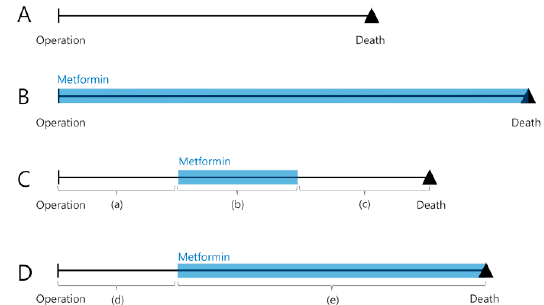
Figure 1. Illustration of the differences in metformin administration periods. ( A ) Patients who did not take metformin until death; ( B ) Patients who continuously took metformin between operation until death; ( C ) Patients who started taking metformin some time after operation and stopped before death; ( D ) Patients who started taking metformin some time after operation and continued until death.